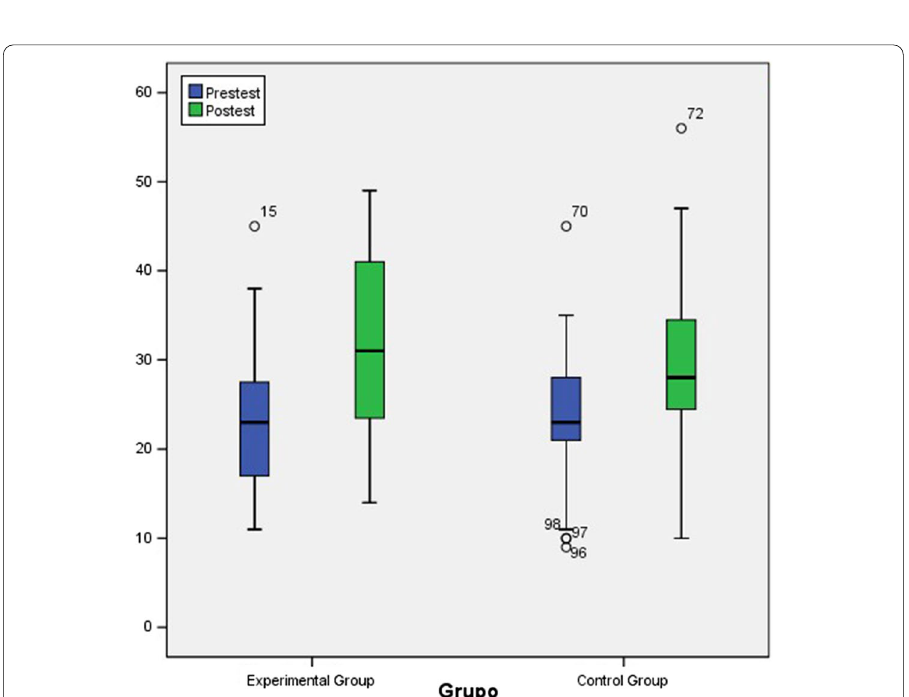
Fig. 4 Boxplot graph experimental and control group